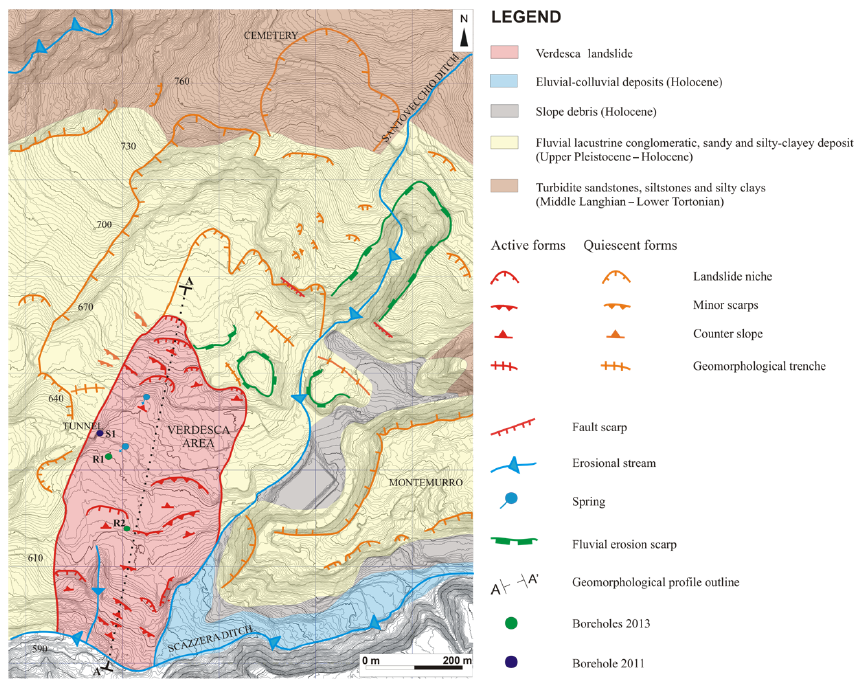
Figure 9. Geomorphological sketch map. The geomorphological profile outline along the A–A (cid:48) trace is illustrated in Fig. 13.